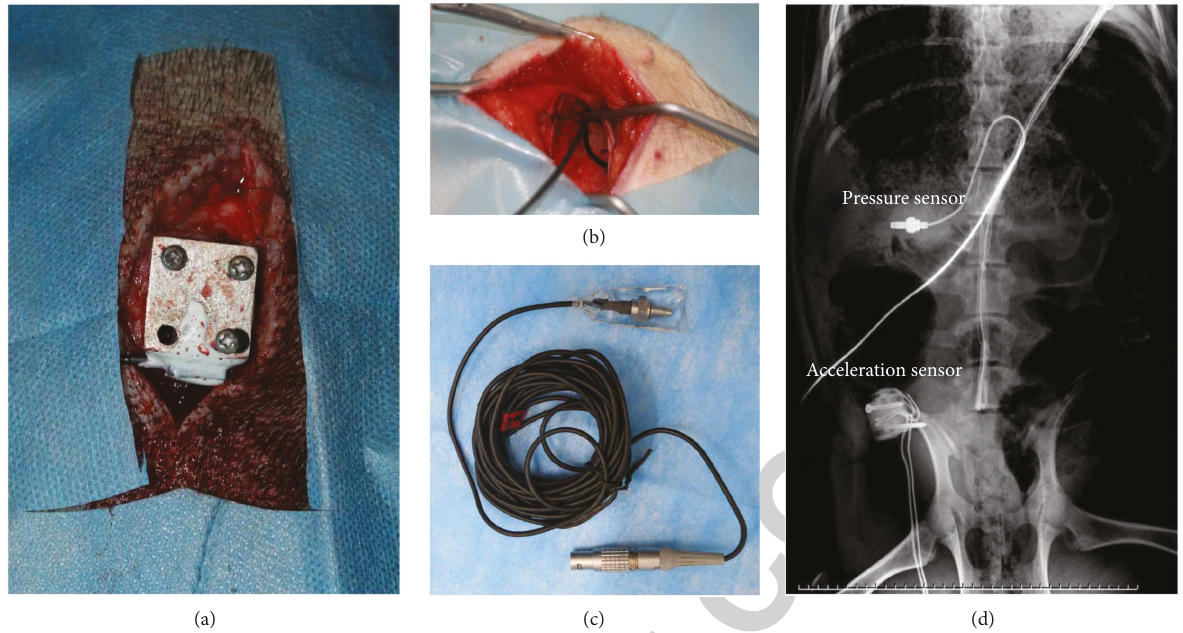
Figure 2: The installation of the sensors. (a) The operation photograph of the acceleration sensor installation. The sensor was glued to a metal block that was mounted on the pelvis via screws. (b) The operation photograph of the pressure sensor installation. The laparotomy was done, and the sensor was placed under the liver. (c) The photograph of the pressure sensor. The sensor was inserted into a balloon fi lled with liquid. (d) The X-ray photograph, in which the sensors were indicated with